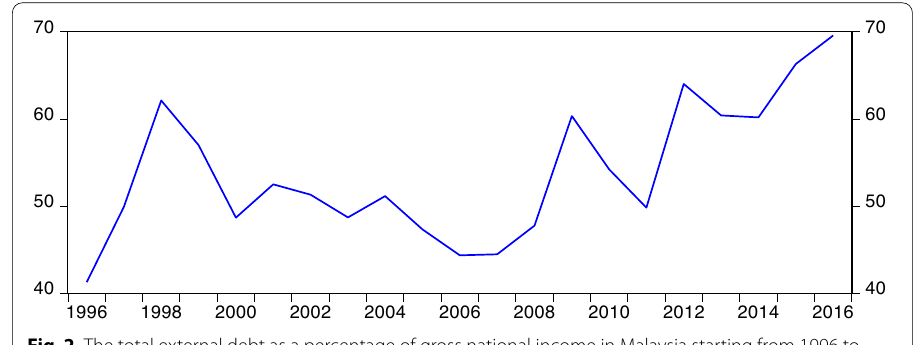
Fig. 2 The total external debt as a percentage of gross national income in Malaysia starting from 1996 to